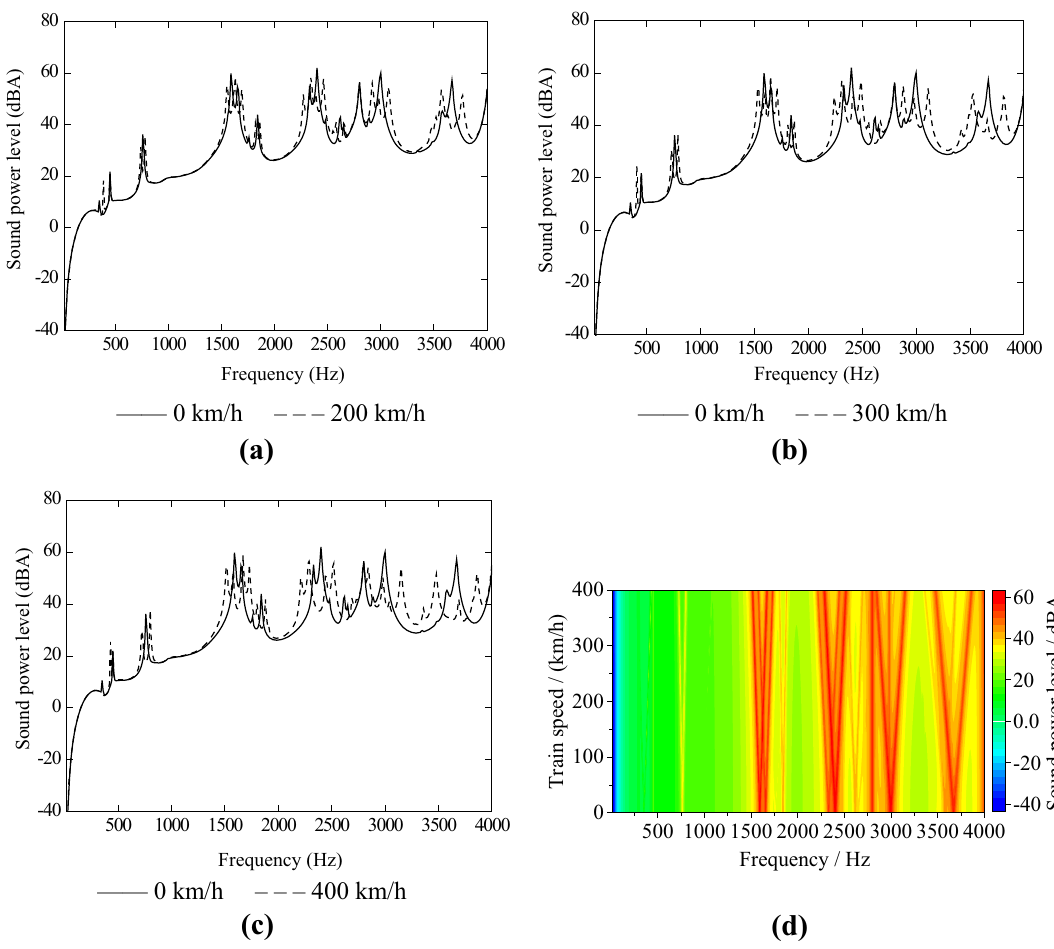
Fig. 11 Influences of the rotation speed on the sound power level of the wheel. a 0 and 200 km/h, b 0 and 300 km/h, c 0 and 400 km/h and d 0–400 km/h